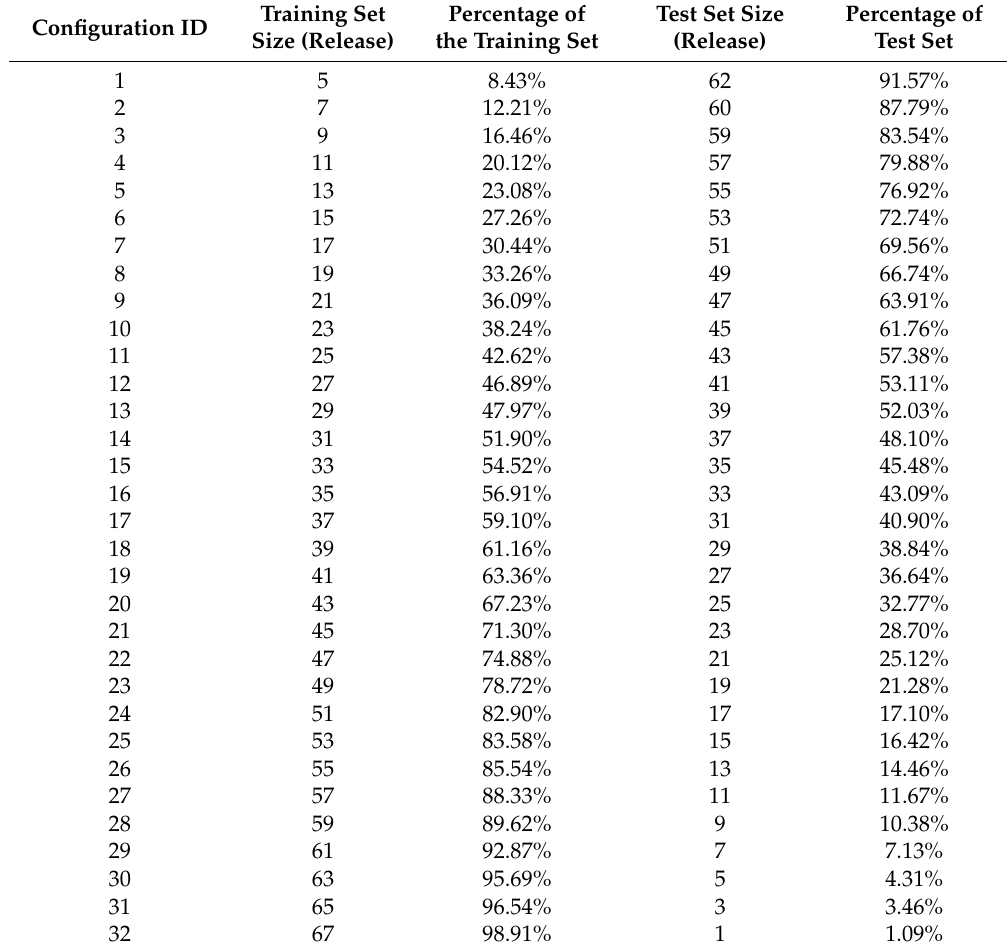
Table A3. The configurations of the training sets and test sets in the Prairie Grass